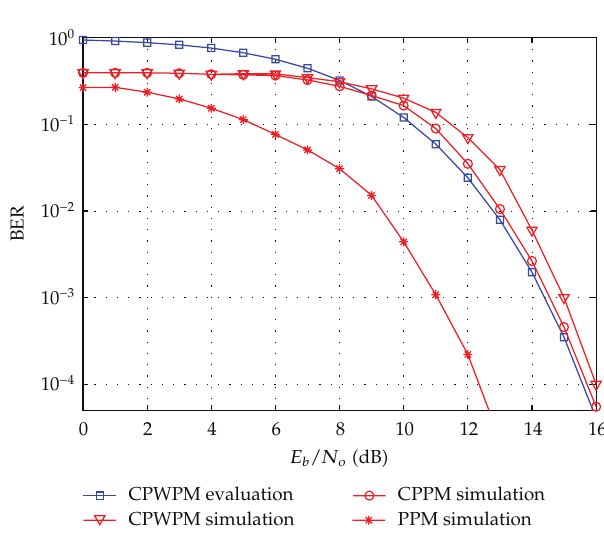
Figure 10: BER performance of CPWPM, CPPM, PPM systems in the AWGN